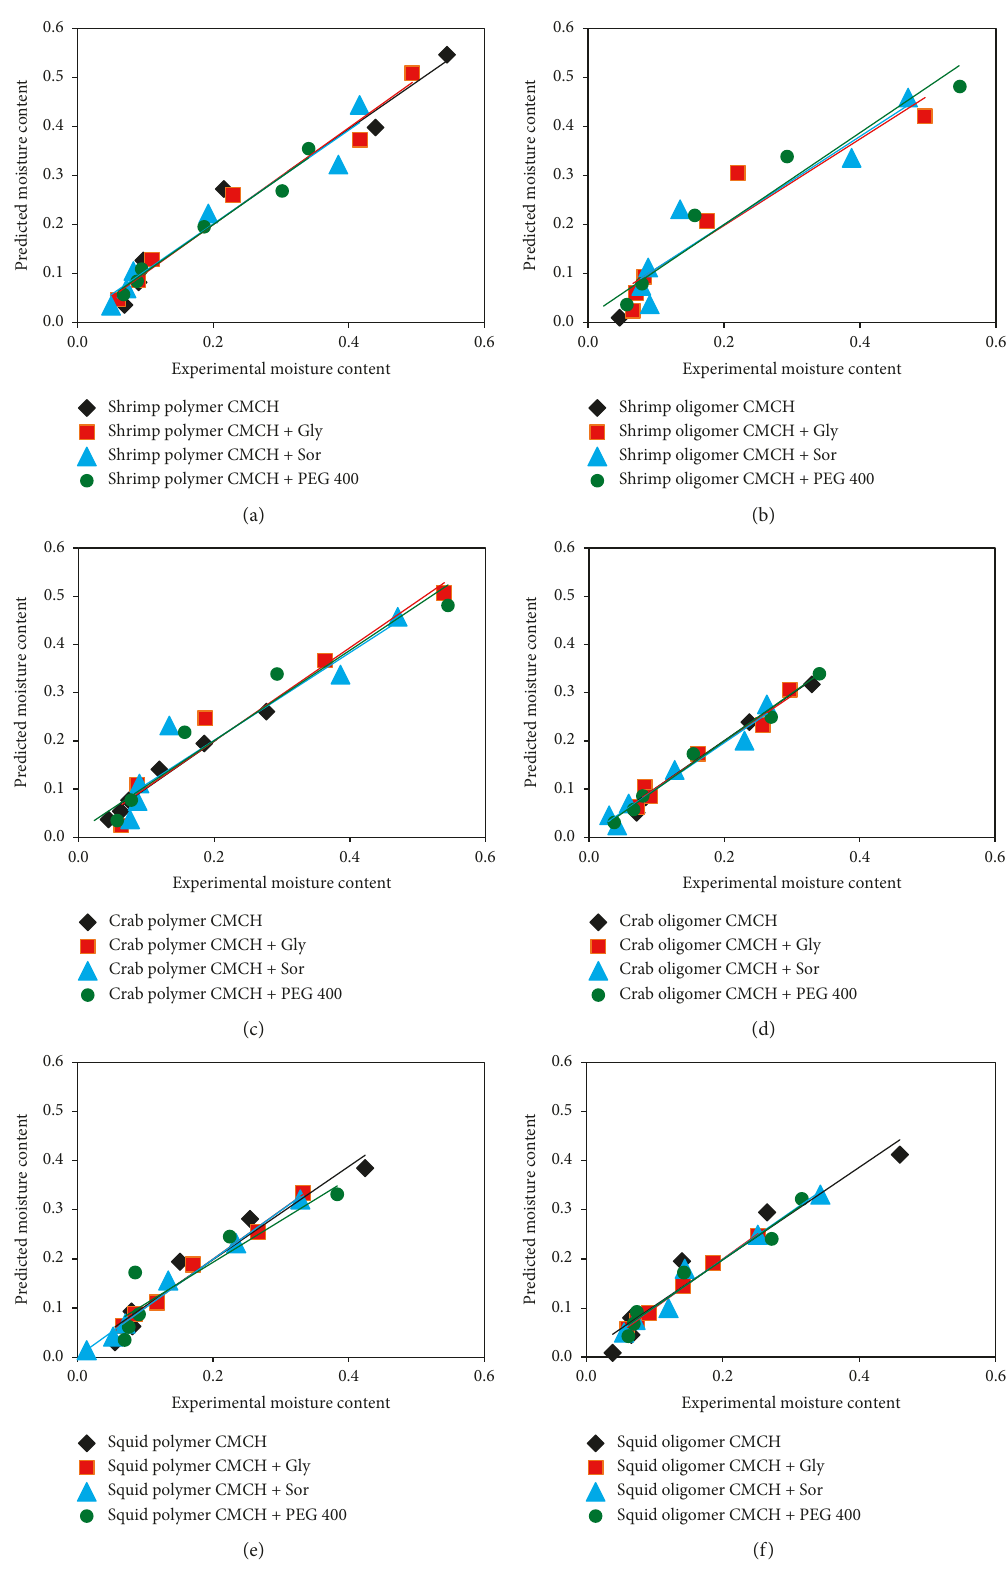
Figure 5: The comparison between the experimental moisture content values and those predicted for all the CMCH films from the Smith model: shrimp polymer CMCH films (a); shrimp oligomer CMCH films (b); crab polymer CMCH films (c); crab oligomer CMCH films (d); squid polymer CMCH films (e); squid oligomer CMCH films